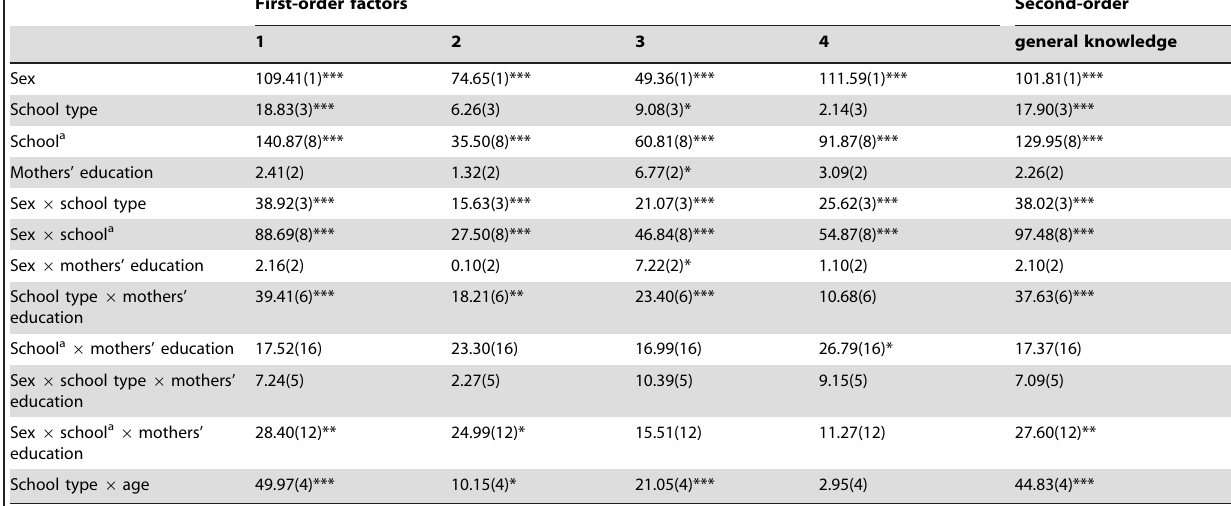
Table 6. Effect Tests in the